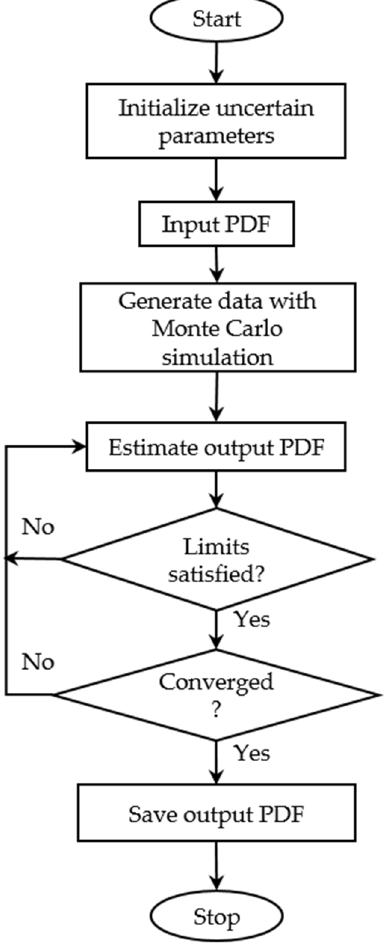
Figure 6. A flowchart of generating scenarios by MCS algorithm.